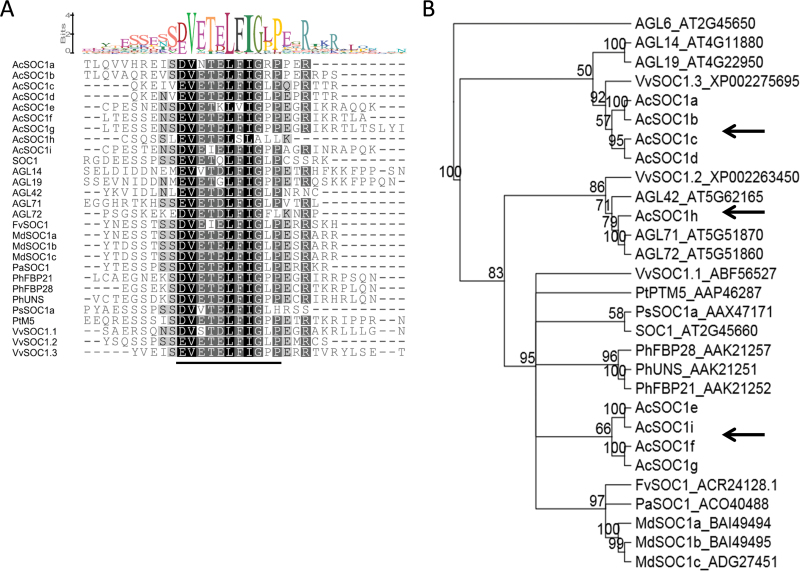
Phylogenetic analysis of kiwifruit SOC1-like protein sequences. (A) Alignment of the C-terminal region of SOC1-like amino acid sequences. The amino acid residues in the alignment are shaded according to their similarity scores: white on black, 100% similar; white on grey, 80–100% similar; black on grey, 60–80% similar; grey on white, <60% similar. The conserved SOC1 motif is underlined. The observed deviation of this motif in AcSOC1h appears to be due to a putative 1bp deletion within the motif leading to a frameshift from EVETELFFGLA to EVETELSLALL. (B) Phylogenetic tree based on the amino acid alignment of kiwifruit SOC1-like predicted proteins and SOC1-like proteins from other plant species. The tree was generated using the Geneious Tree Builder plug-in (Geneious 5.5.6) using the Neighbor–Joining method with Arabidopsis AGL6 as an outgroup. Numbers below the branches represent bootstrap support values from 1000 replicates (values ≥50% are indicated). Origins of the genes, with the exception of Arabidopsis, are indicated by a prefix as follows: Ac, Actinidia chinensis; Vv, Vitis vinifera; Pt, Populus tremuloides; Ps, Pisum sativum; Ph, Petunia hybrida; Fv, Fragaria vesca; Pa, Prunus armeniaca; Md, Malus×domestica; their GenBank accession numbers are indicated to the right. Arabidopsis genes SOC1, AGL14, AGL19, AGL42, AGL71, and AGL72 are associated with their unique IDs. Kiwifruit SOC1-like genes in different clades are indicated by arrows. (This figure is available in colour at JXB online.)